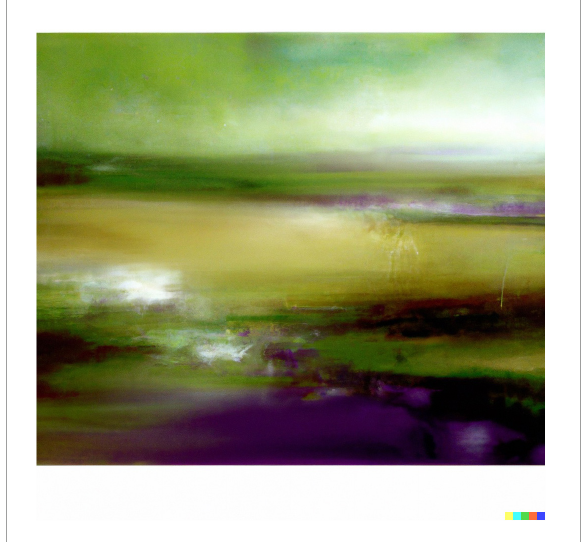
FIGURE5 Dall-E generated image to the prompt “a Surreal Impressionist Landscape”.